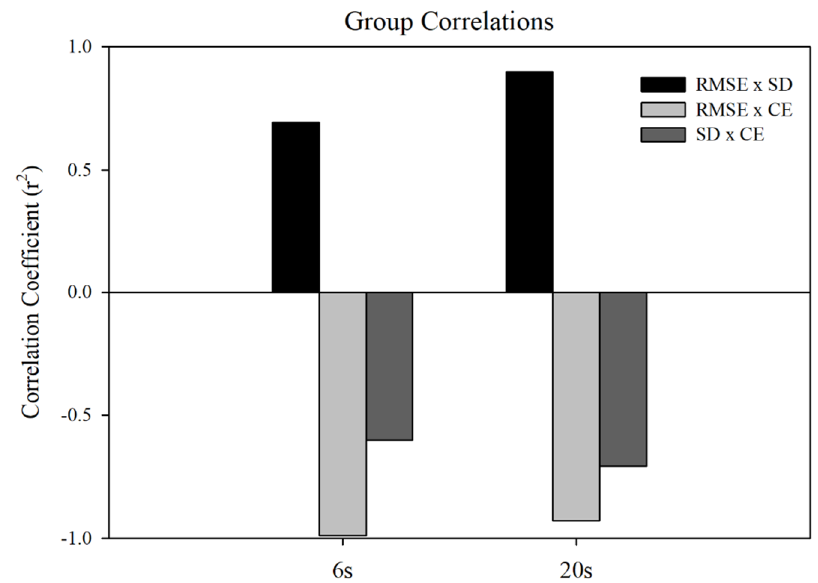
Correlations: Figure 3 shows the correlations between RMSE and SD, RMSE and CE, and SD and CE, as a function of MVC group. The correlations were run over all Ss within each group and included all individual trials at each force level.